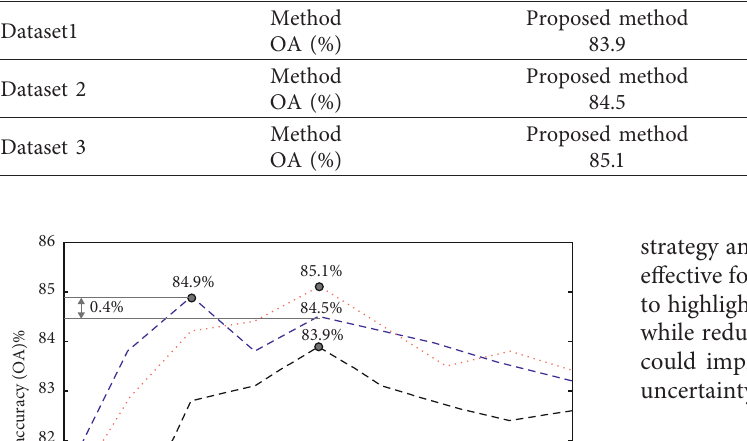
Figure 8: CD maps of patches I5 and I6: (a-b) patch I5; (c) reference map of Patch I5; (d–i) CD maps obtained in patch I5 using the proposed method and Methods 1, 2, 3, 4, and 5, respectively; (j-k) patch I6; (l) reference map of patch I6; (m–r) CD maps obtained in patch I6 using the proposed method and Methods 1, 2, 3, 4, and 5, respectively. Table 7: OA of the proposed method, Method 6, and Method 7.